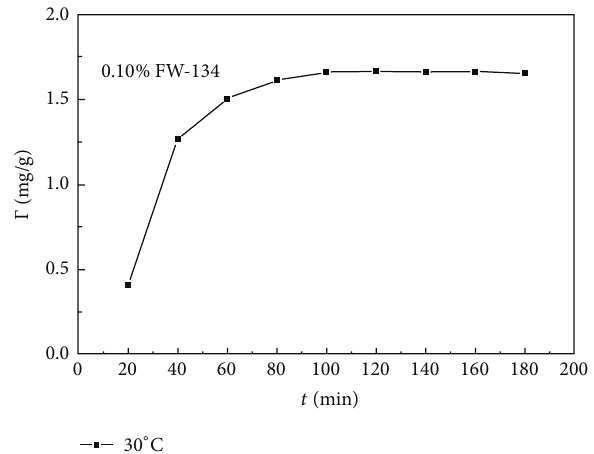
Figure 1: FW-134 adsorption capability on mica versus time.